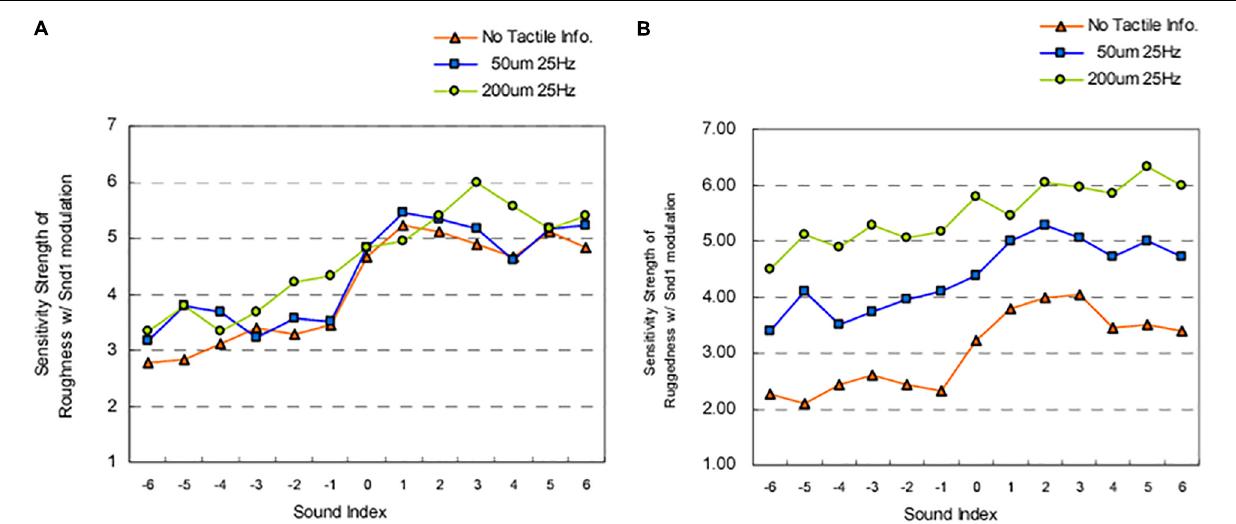
FIGURE 4 | Results from Kim et al.’s (2007) study evaluating the influence of amplifying and attenuating sound frequency components on: (A) perceived roughness; (B) perceived ‘ruggedness.’ Snd1 = Sound 1 the sound of rubbing sandpaper (Sound 1, grit size #24) was provided alone (“no Tactile info”), or was paired with haptic interaction (index finger) using two different tactile settings on a texture display mouse. The auditory stimuli were divided into various sound frequencies (where 1 = 20–36 Hz; 2 = 36–56 Hz; 3 = 56–96 Hz; 4 = 96 – 174 Hz; 5 = 174 – 284 Hz; 6 = 284 – 584 Hz) that were either amplified by 20 dB (+) or attenuated by 20 dB (–). The sound index ( x -axis) refers to the frequency-intensity combination. The Sensitivity strength ( y -axis) refers to ratings provided on 7-point Likert scale (midpoint = neutral) for perceived roughness and ruggedness. These results highlight that amplifying a 30 – 600 Hz frequency range results in increased perceptions of roughness in all conditions. Amplifying a 30 – 300 Hz frequency range results in increased perceptions of ruggedness during virtual haptic interaction (touch conditions) and 56 – 96 Hz during no sound conditions. [From Figures 4 , 7 of Kim et al. (2007). Reprinted, with permission from IEEE Proceedings (Computer Society) in the format Republish in a journal/magazine via Copyright Clearance